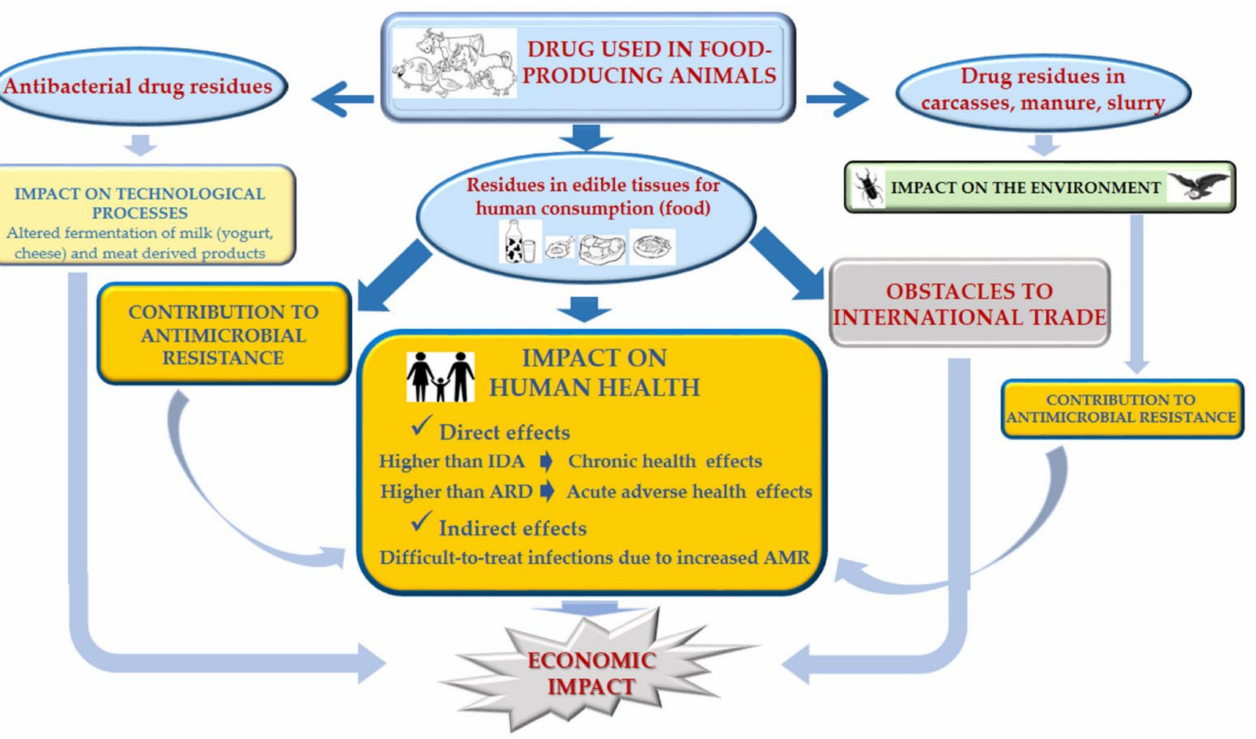
Figure 2. Schematic representation of the main adverse consequences of the presence of drug residues in edible animal